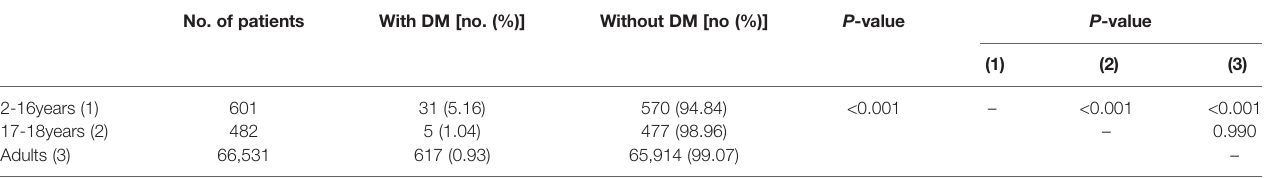
TABLE 4-1 | Comparison of different age groups with distant metastasis of CPTC. No. of patients